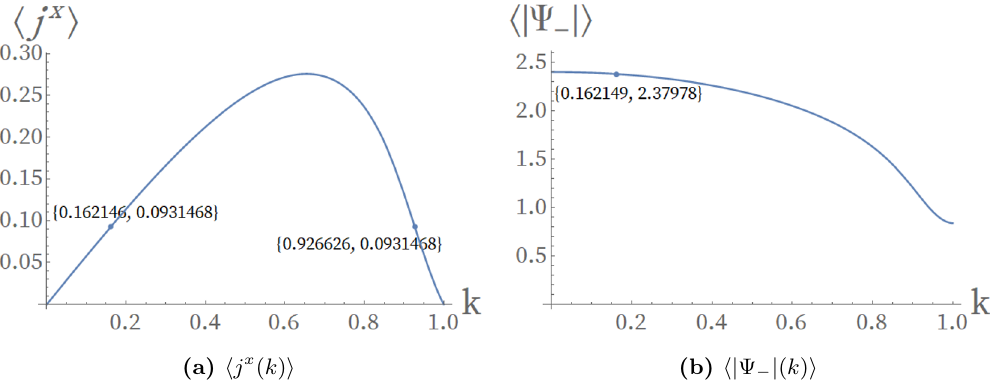
Figure 9. Relations between h j x i and k as well as h| Ψ − |i and k . Both figures are obtained by interpolation with discrete value of k, so the value 0.162146, 0.926626 and 2.37978 is not exact. The non-monotonicity for h j x i gives two states with different k , while the monotonicity for h| Ψ − |i excludes the larger k